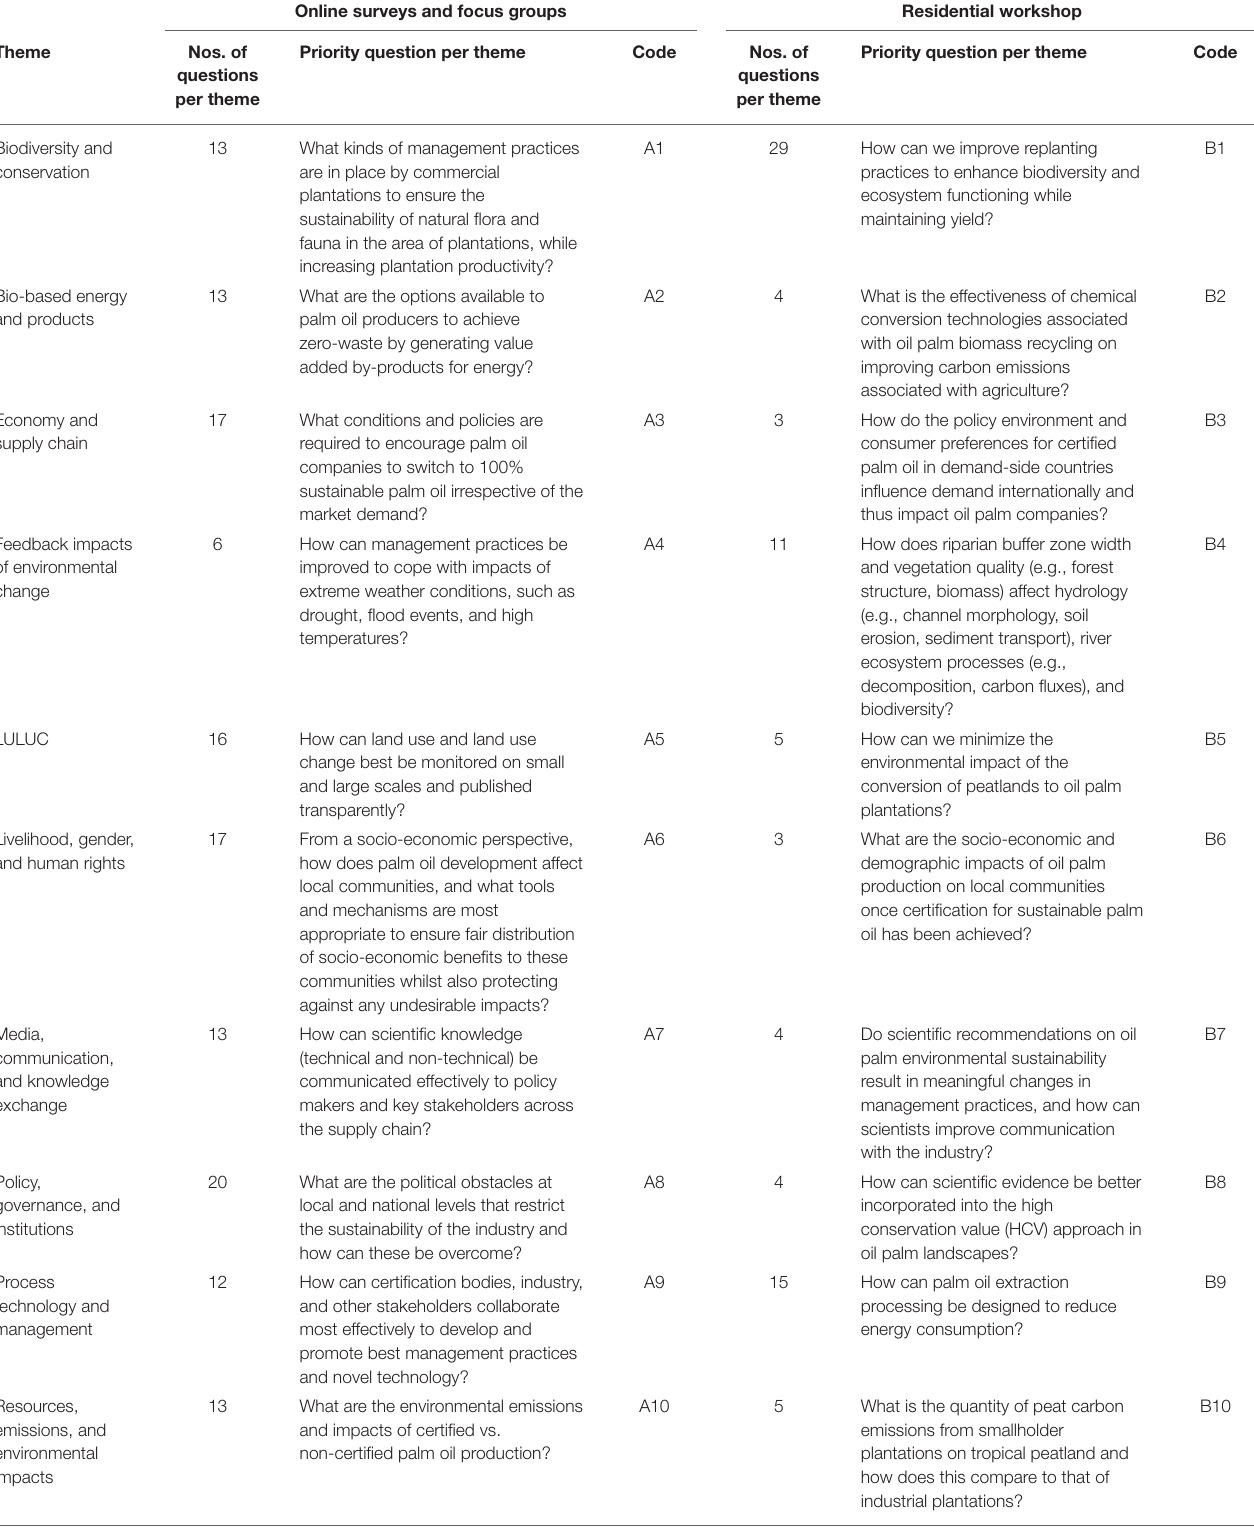
TABLE 3 | The highest priority question and number of questions by theme according to the online surveys and focus groups, and the residential workshop. Online surveys and focus